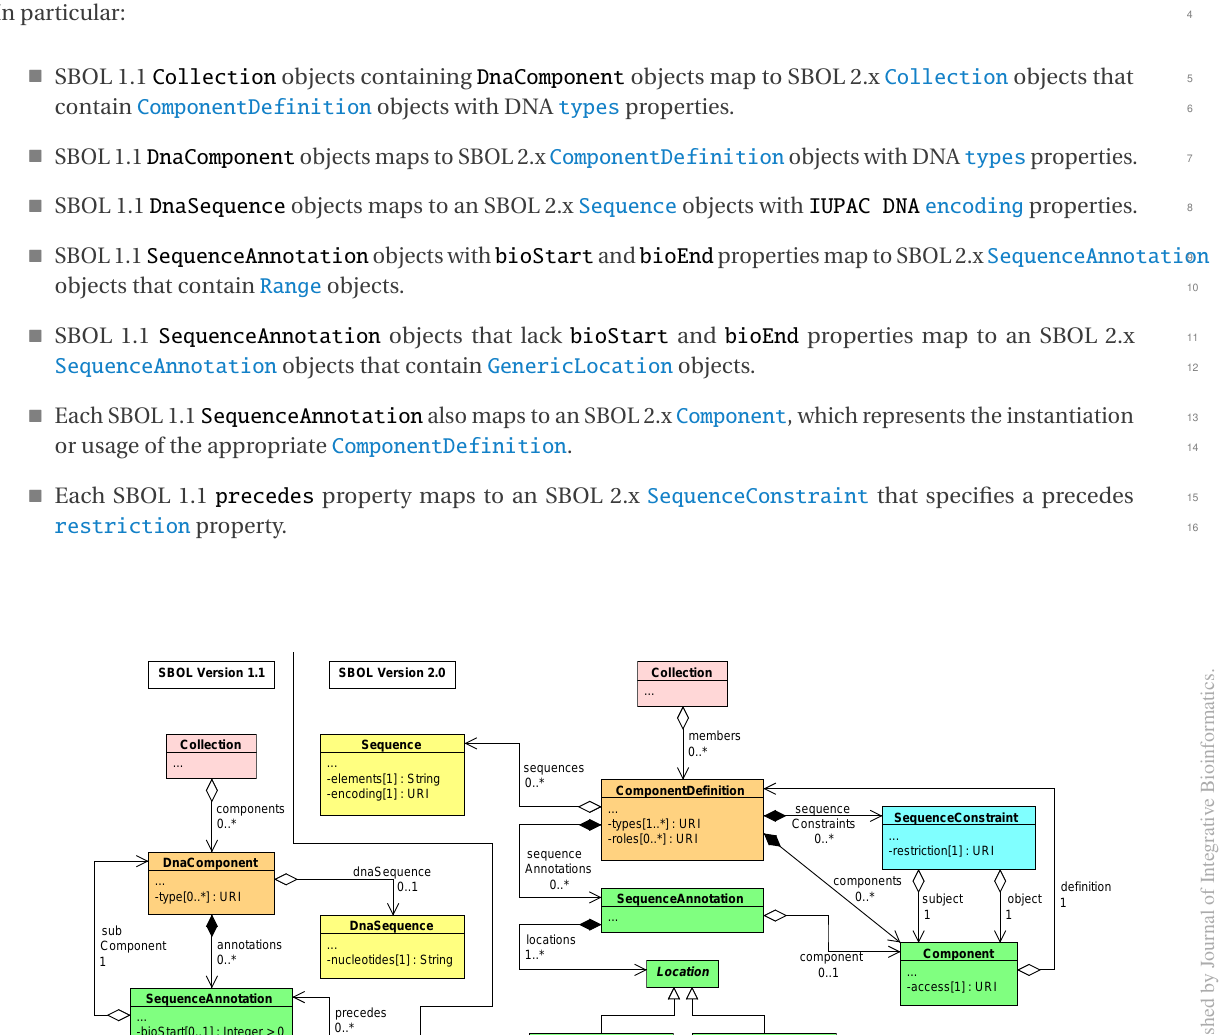
Figure 22 depicts the mapping of SBOL 1.1 classes to SBOL 2.x classes, indicating corresponding classes/properties by color. The SBOL 2.x Model and ModuleDefinition classes have no SBOL 1.1 equivalent, and thus are not shown.